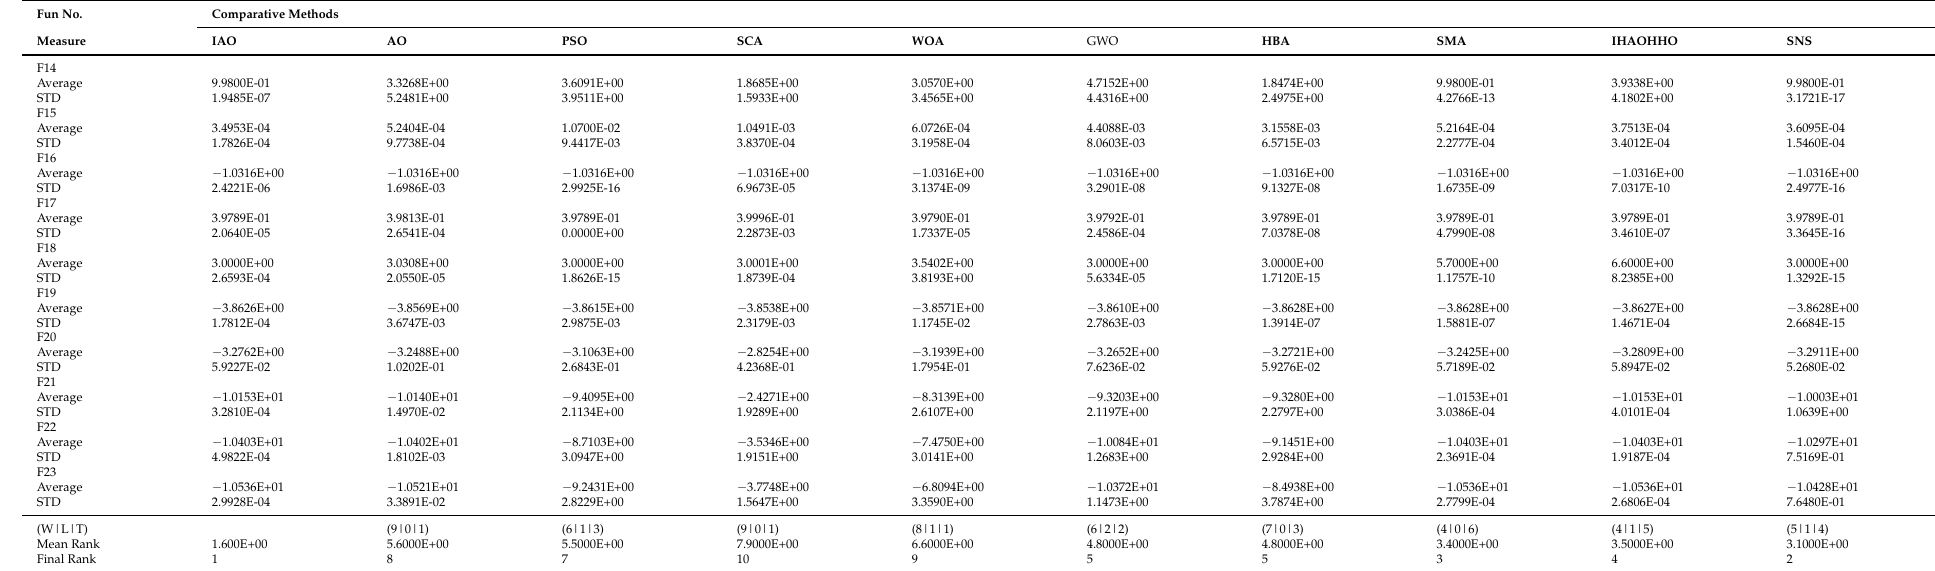
Table 8. Results of the comparative methods on classical test functions (F14–F23).